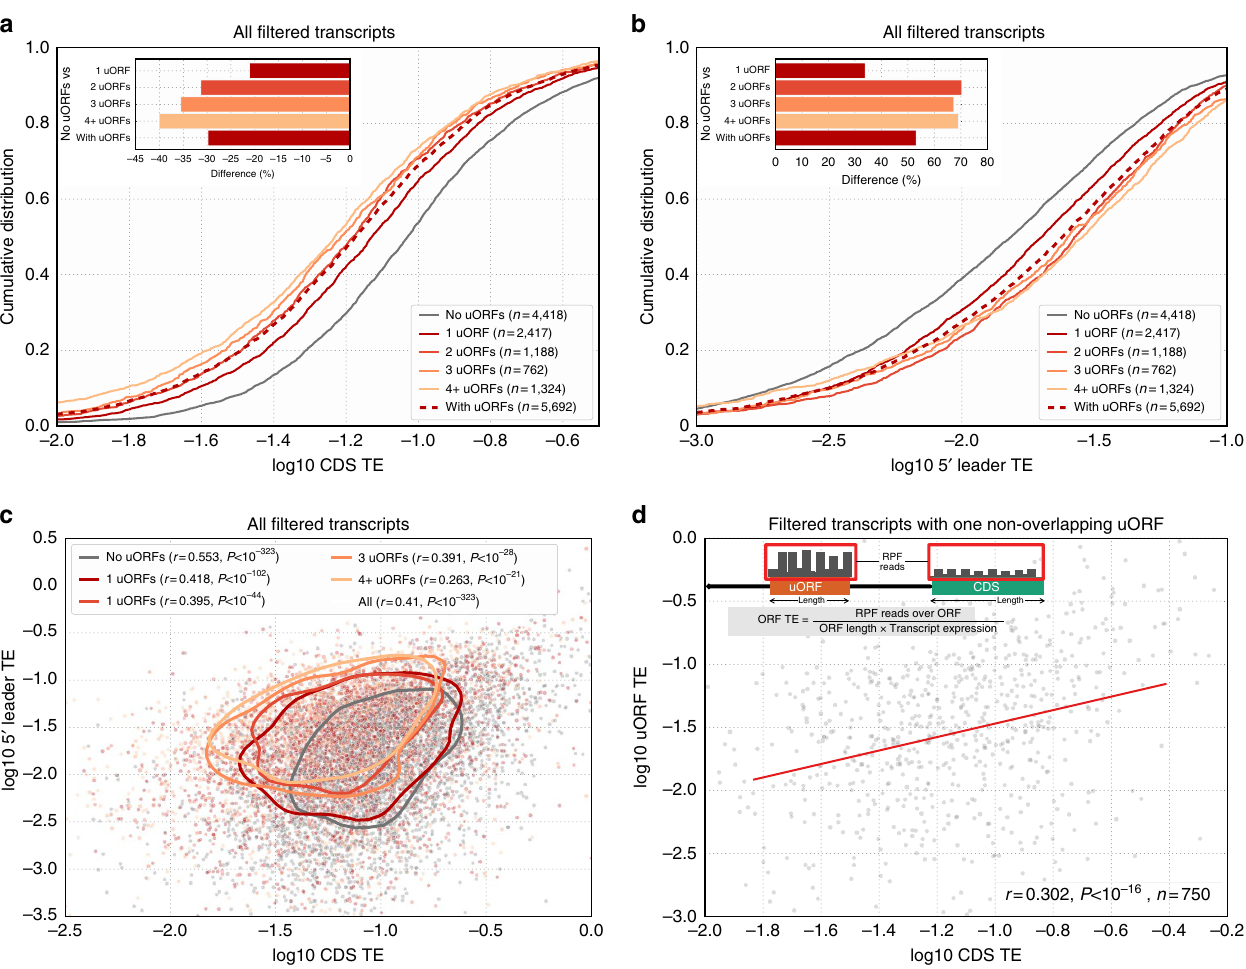
Figure 2 | uORFs are modestly repressive on an average. ( a ) Cumulative distribution of CDS TEs in transcripts grouped by their number of uORFs. The presence of uORFs is associated with a reduction of CDS TEs (inset; between 21 and 40% reduction with increasing number of uORFs, averaging 30%). ( b ) Cumulative distribution of 5 0 leader TEs in transcripts grouped by their number of uORFs. The presence of uORFs is associated with an increase in 5 0 leader TEs (inset; between 33 and 71% increase with increasing number of uORFs, averaging 53%). ( c ) Relationship between 5 0 leader and CDS TE in transcripts with varying numbers of uORFs. While having more uORFs is associated with increased 5 0 leader TE and reduced CDS TE, overall, 5 0 leader and CDS TEs correlate with each other ( r ¼ 0.41, P o 10 (cid:2) 323 ). Contours indicate the 20th percentile values of a bivariate Gaussian kernal density estimator for each subset of transcripts. ( d ) uORF TEs correlate with cognate CDS TEs for transcripts with one non-overlapping uORF. Red line indicates ridge regression linear fit. Transcript schematic outlines how TEs of individual ORFs are calculated. uORF TEs correlate weakly, but significantly and positively with cognate CDS TEs ( r ¼ 0.302, P o 10 (cid:2)